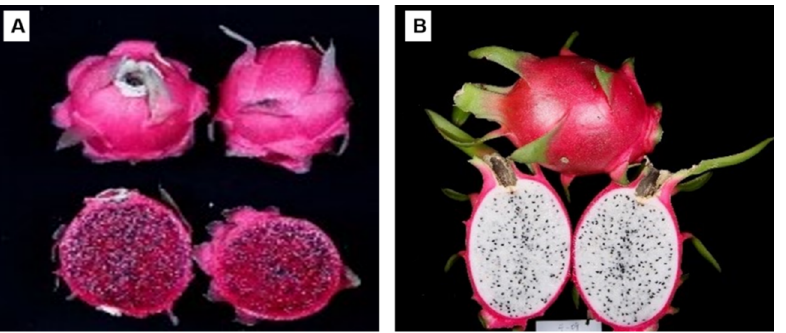
Figure 1. Fruit appearance of the red-fleshed H. monacanthus as the diploid female parent (13-7) ( A ) and white-fleshed H. undatus as the diploid male parent (4-09) ( B ) were crossed to develop the F 1 mapping